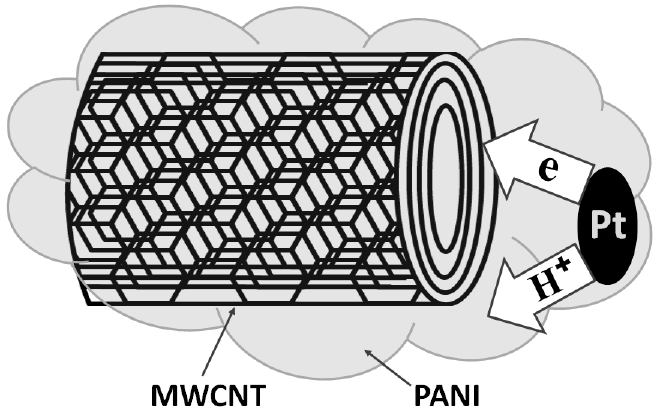
Figure 6. Schematic describing the pathways for the flow of charges in a